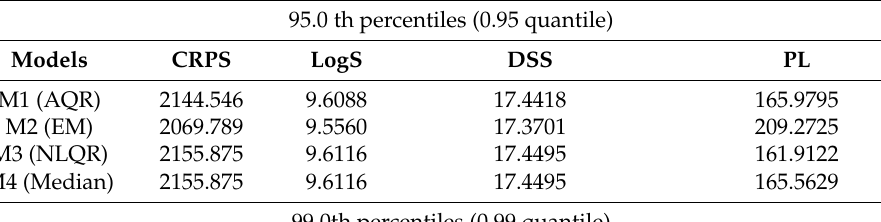
Table 4. Model comparisons (extremely high